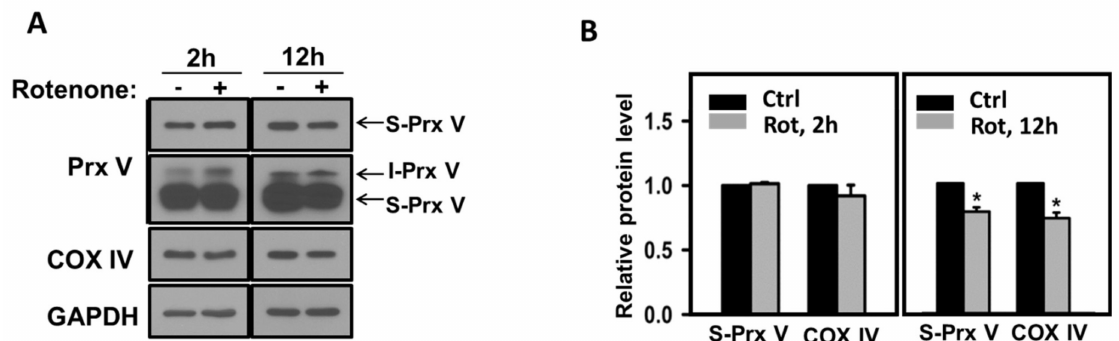
Figure 3. Effect of rotenone on L-Prx V maturation. HeLa cells transfected with LPrx V were treated with or without rotenone (2 µ M) for 2 or 12 h and harvested. ( A ) Protein levels of Prx V, COX IV, and GAPDH in the harvested cells were measured by immunoblotting with antibodies to indicated proteins. Two different blot exposures are shown for Prx V blot. ( B ) The band intensities of S-Prx V and COX IV are normalized to the intensity of GAPDH. Data are means ± SE ( n = 3 per group), * p < 0.05.